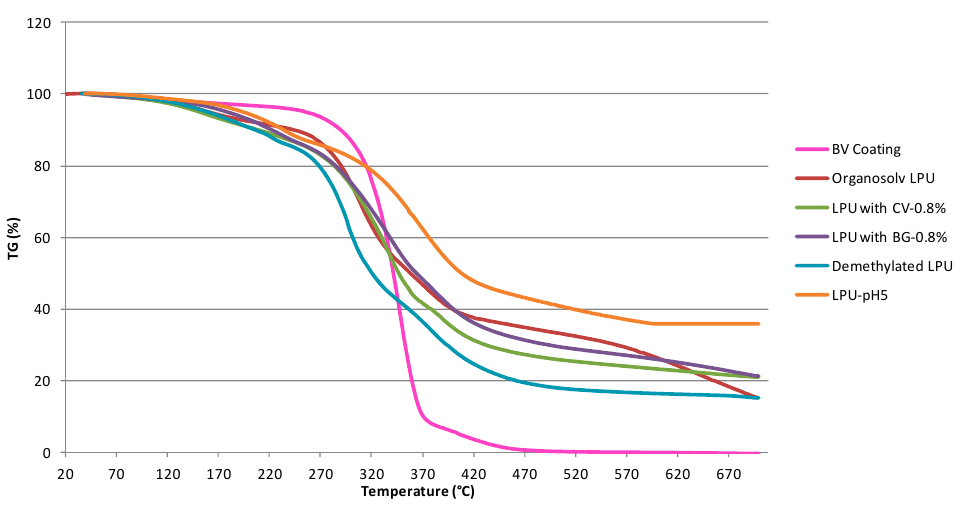
Figure 5. TGA results of different modified lignin-based LPU coatings containing brilliant green (BG) and crystal violet (CV); BV (blind value: PU without lignin).